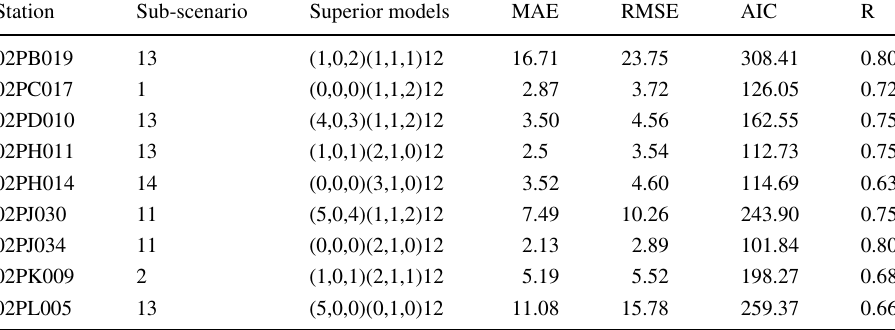
Table 5 Mathematical criteria results of superior models in various stations for determining the best linear model